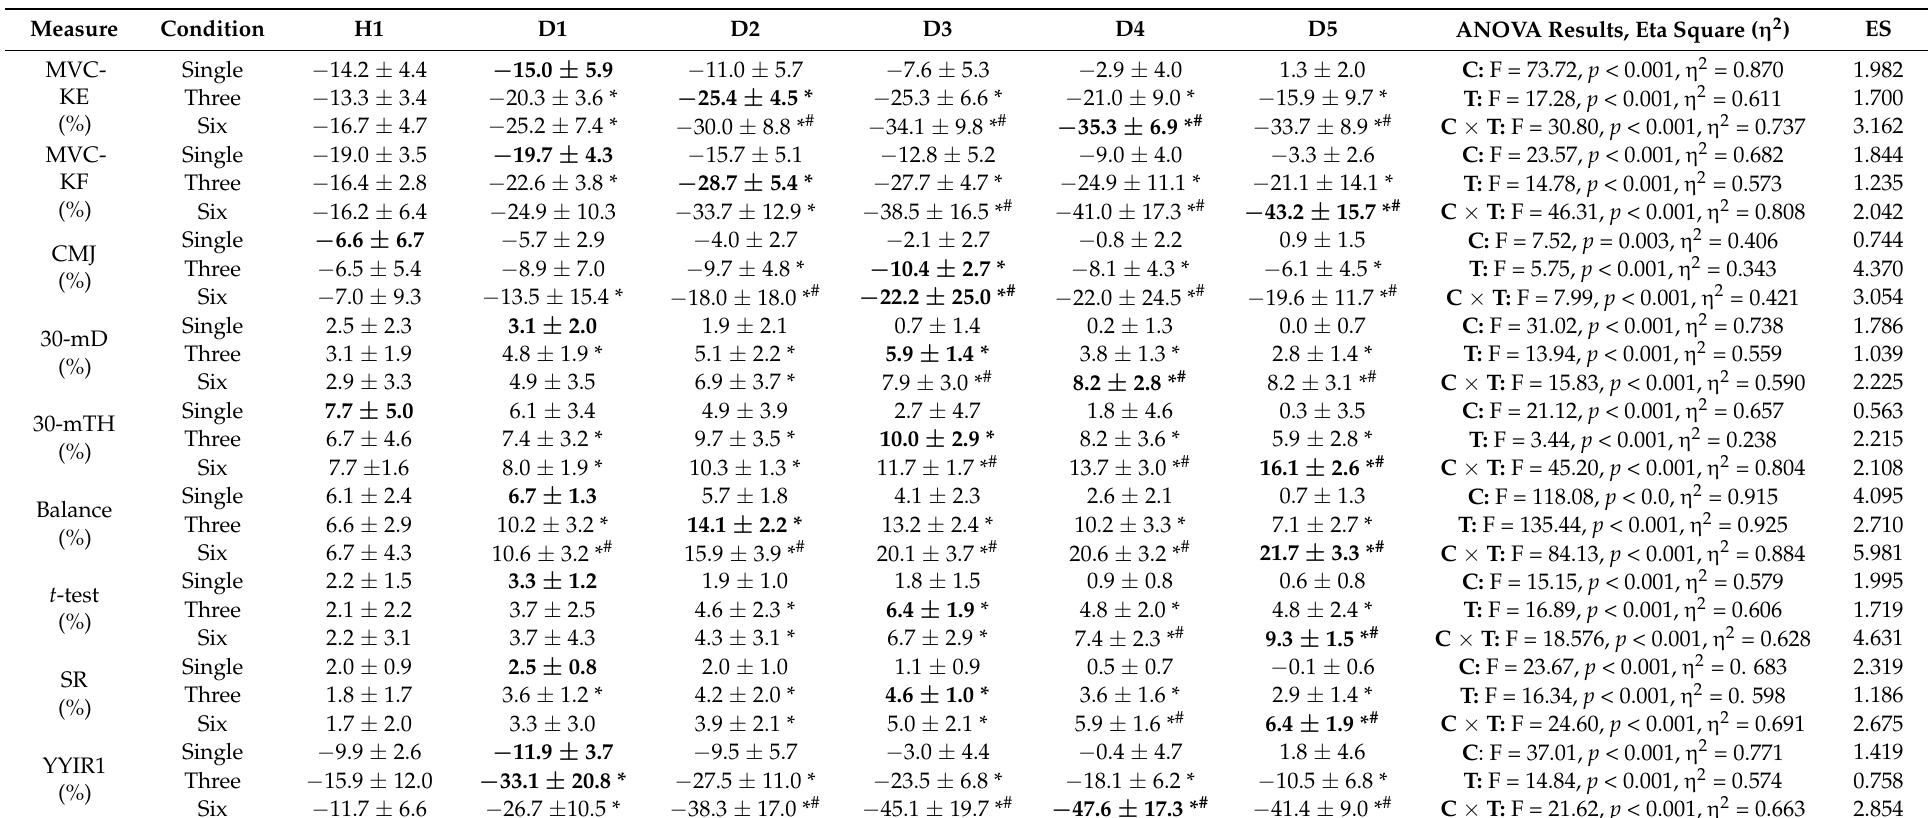
Table 1. Comparison among the single, three, and six Loughborough Intermittent Shuttle Test (LIST) conditions for changes (mean ± SD) in maximal voluntary isometric contraction torque of the knee extensors (MVC-KE) and flexors (MVC-KF), countermovement jump height (CMJ), 30-m dash (30-mD), 30-m timed hop (30-mTH), balance, agility t -test ( t -test), 6 × 10-m shuttle run (SR) and Yo-Yo Intermittent Recovery level 1 (YYIR1) from baseline at 1 h (H1) and 1–5 d after the 1st LIST